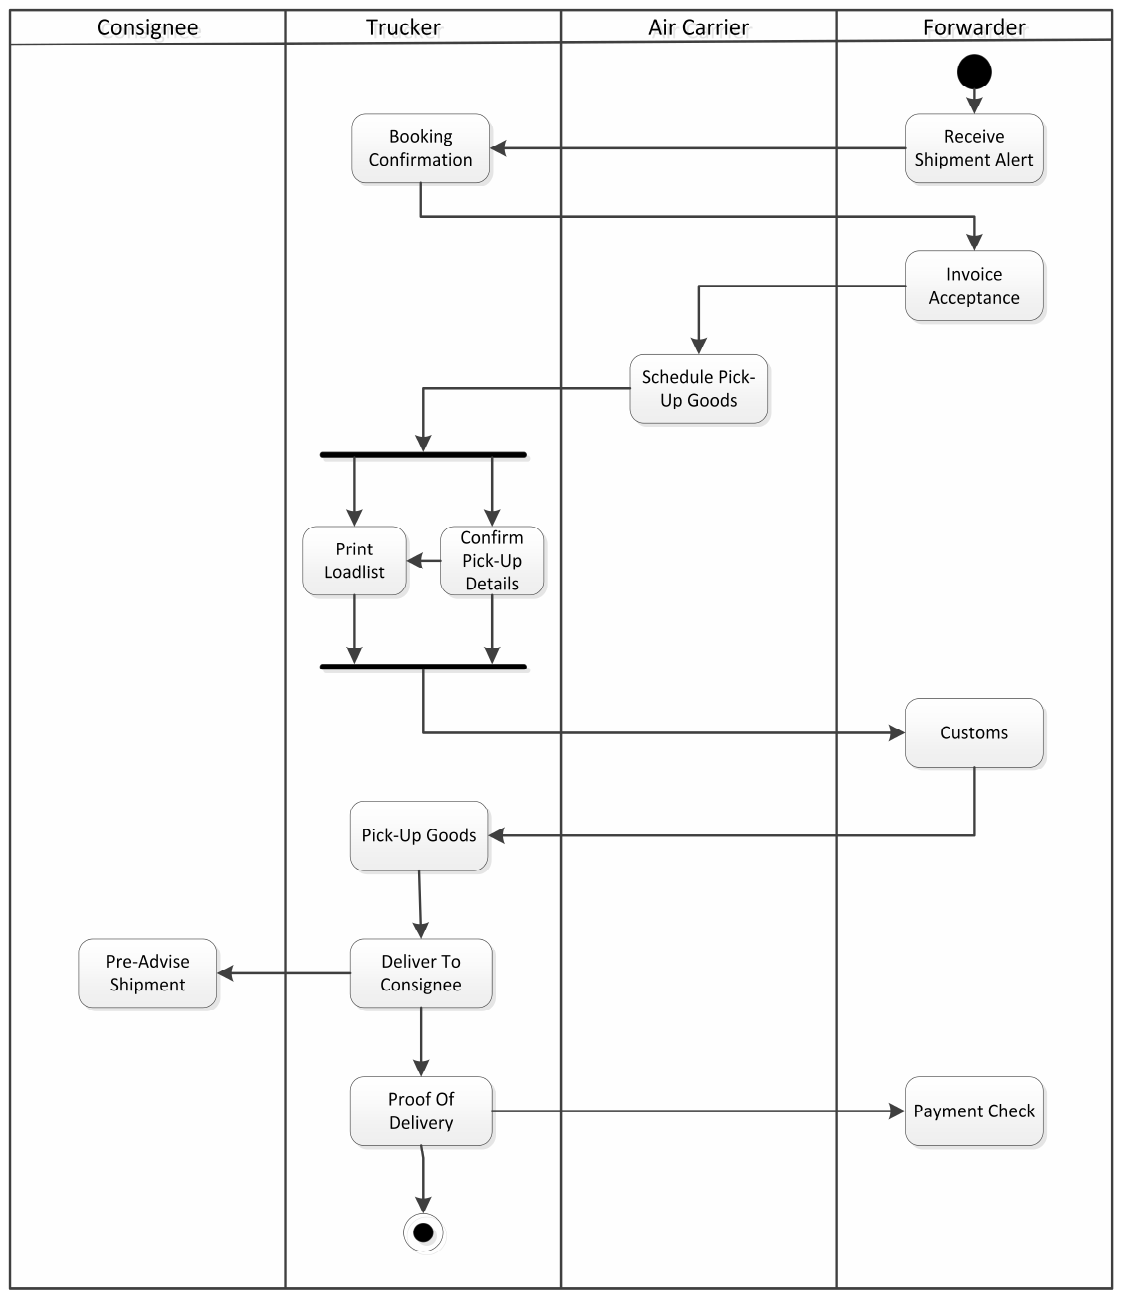
Figure 2. Focus area of the considered air transportation chain following [28].